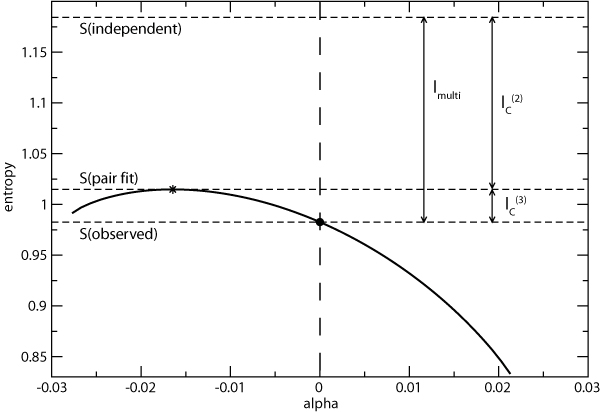
The Shannon entropy for the family of all triplet distributions having the same univariate and bivariate marginals as the data for the triplet 46-54-90 (PI2+ cohort) plotted as a function of the parameter α defined in Equation 8. The observed distribution is indicated by the filled circle, and the entropies of the independent model (Sind), the model with only pair interactions (Spair) and the observed data (Sobs) are indicated, as well as Imulti and the connected information measures  and . Spair is the entropy of the distribution denoted by (A, B, C) in the text which has the maximum entropy subject to the constraints that all of the univariate and bivariate marginals are the same as the observed distribution, and is denoted in the figure by a star.